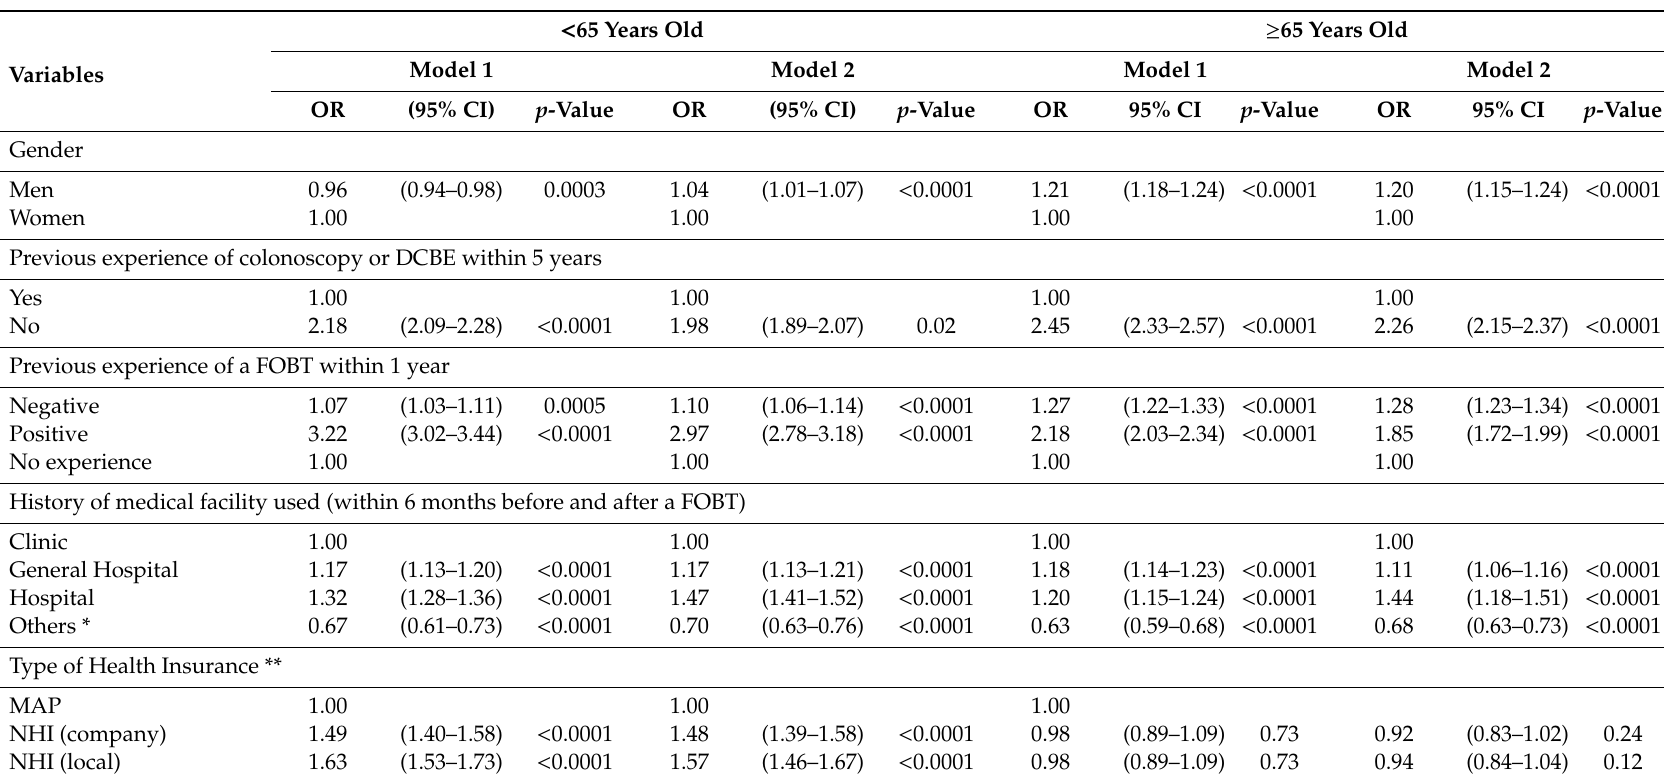
Table 3. Clinical factors associated with adherence to the follow-up test after a positive FOBT, depending on the age group (65 years